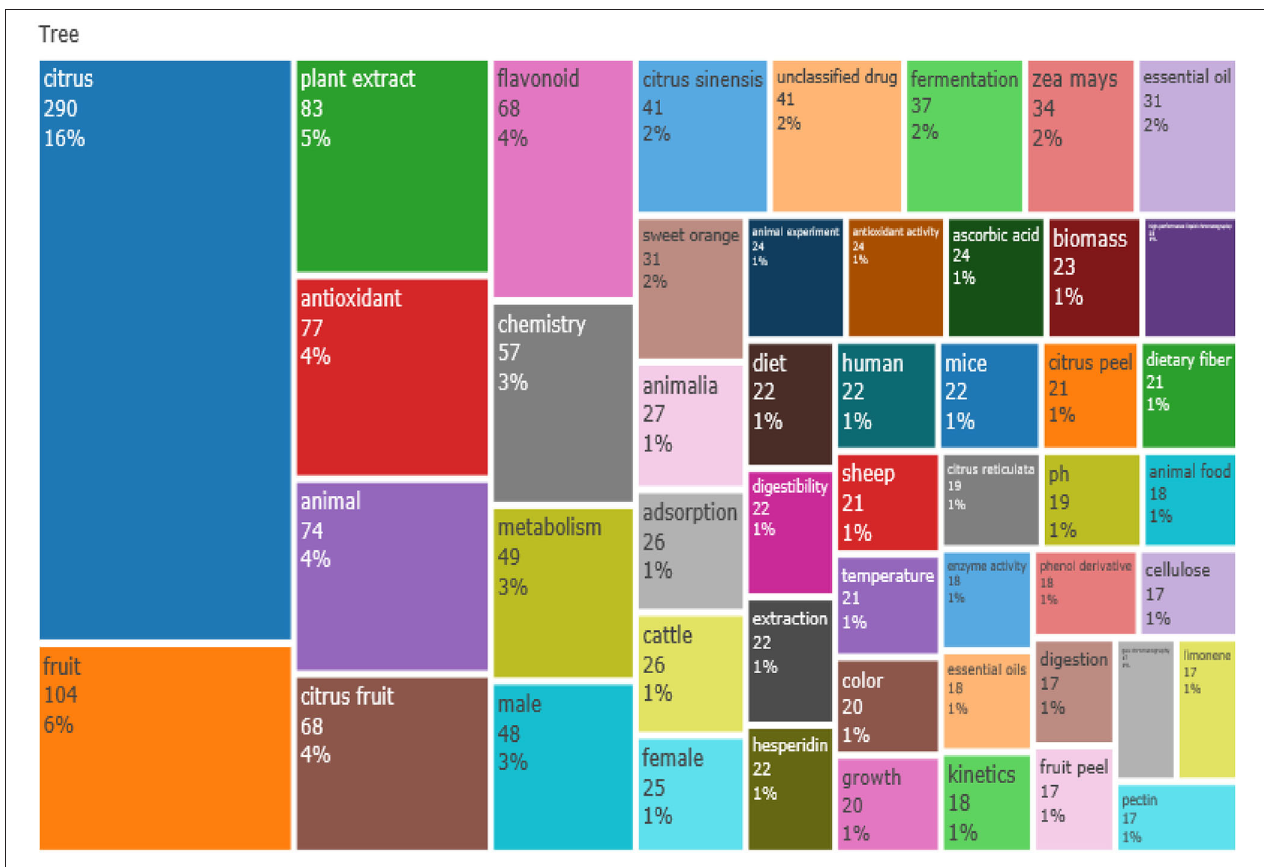
FIGURE 5 | Tree map of discipline distribution in the field citrus waste and livestock feed